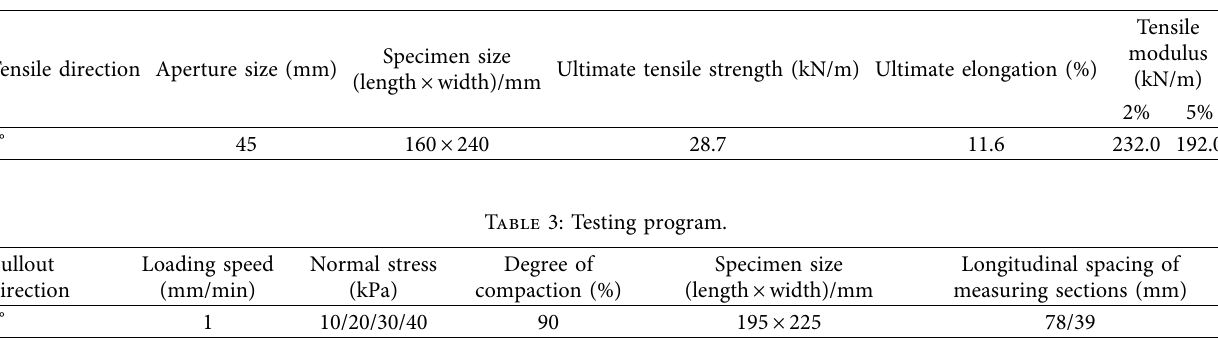
Table 2: Physical and mechanical properties of the triaxial geogrid.